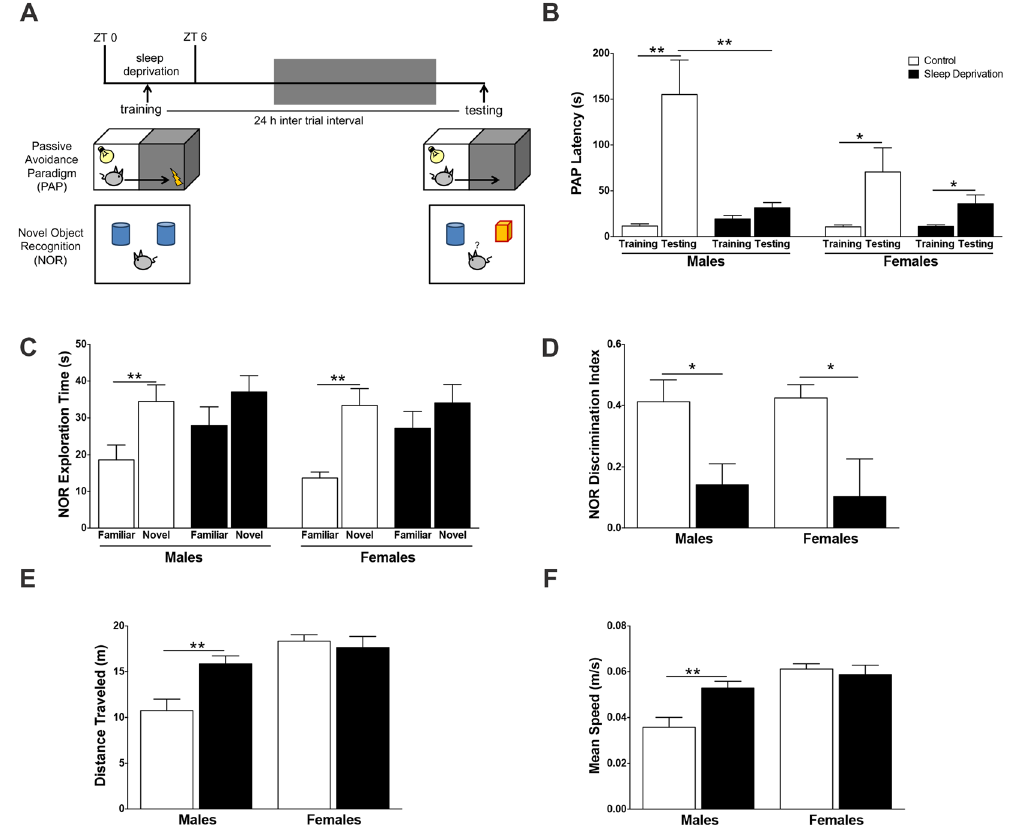
Figure 3. Sleep deprivation impairs both contextual and recognition memory in male rats, but only recognition memory in female rats. (A) Schematic representation of standard behavioral task to assess contextual memory, passive avoidance paradigm (PAP), and recognition memory, novel object recognition (NOR). Male and female animals were sleep deprived for 6 h from ZT 0 to ZT 6. (B) PAP Latency. (C) NOR exploration time during testing trial. (D) NOR discrimination index during testing trial. (E) Distance traveled during training trial of NOR. (F) Mean speed during training trail of NOR. All data are mean ± SEM. * P < 0.05, ** P < 0.01. N = 8 − 12 per